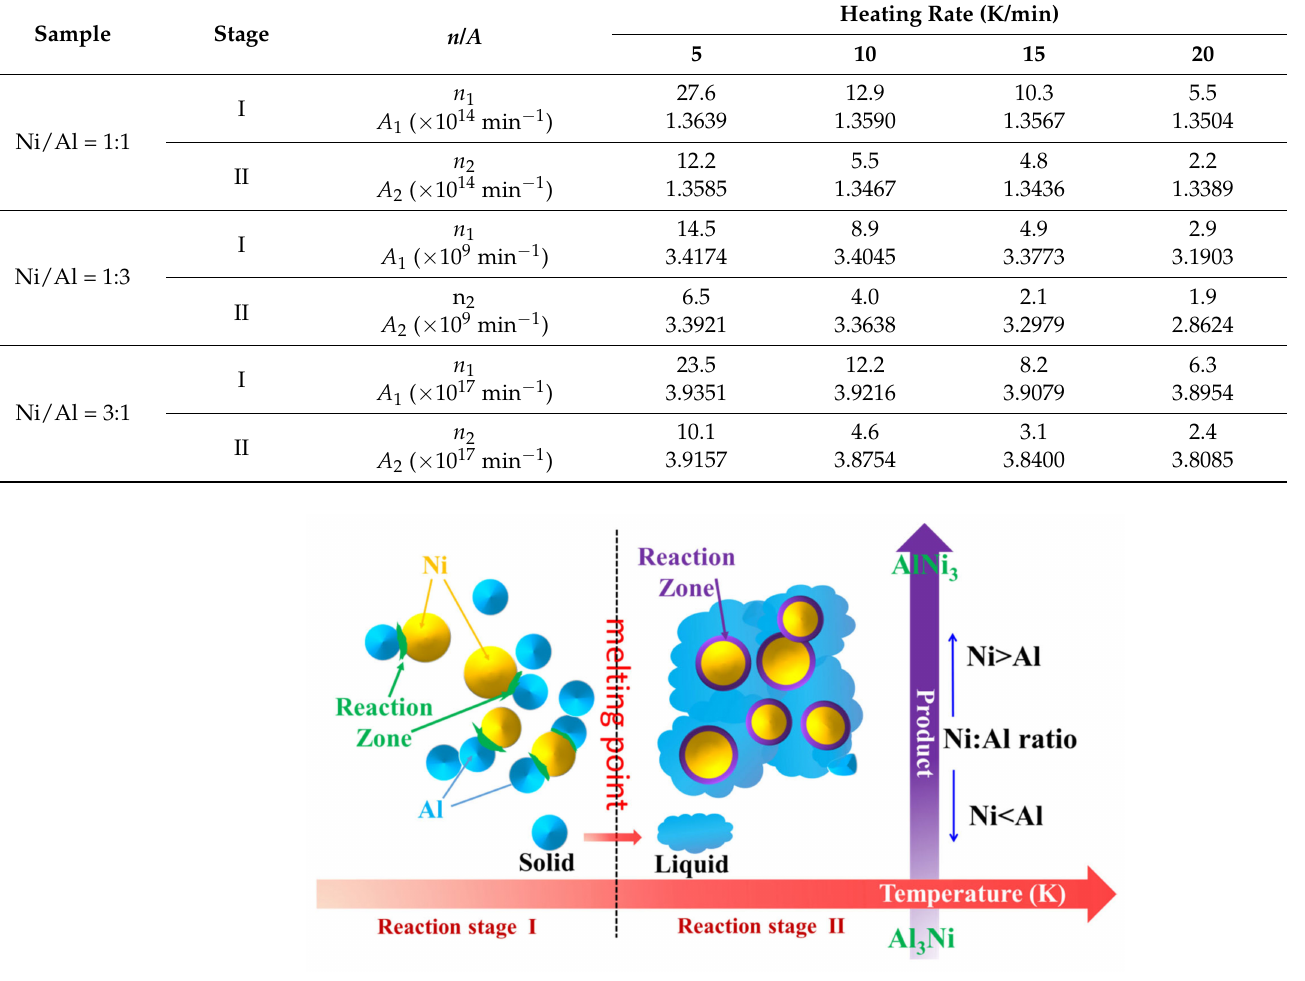
Figure 6. Schematic diagram of the reaction mechanism of Ni/Al